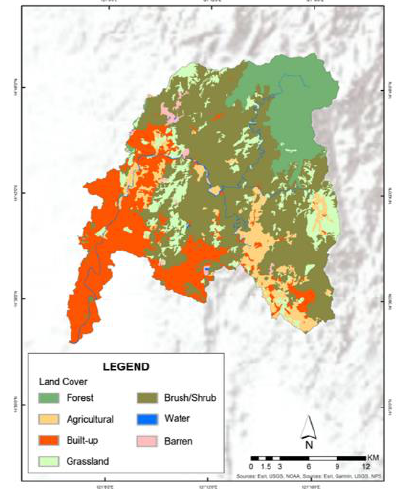
Figure 3. Marikina River Basin Land Cover